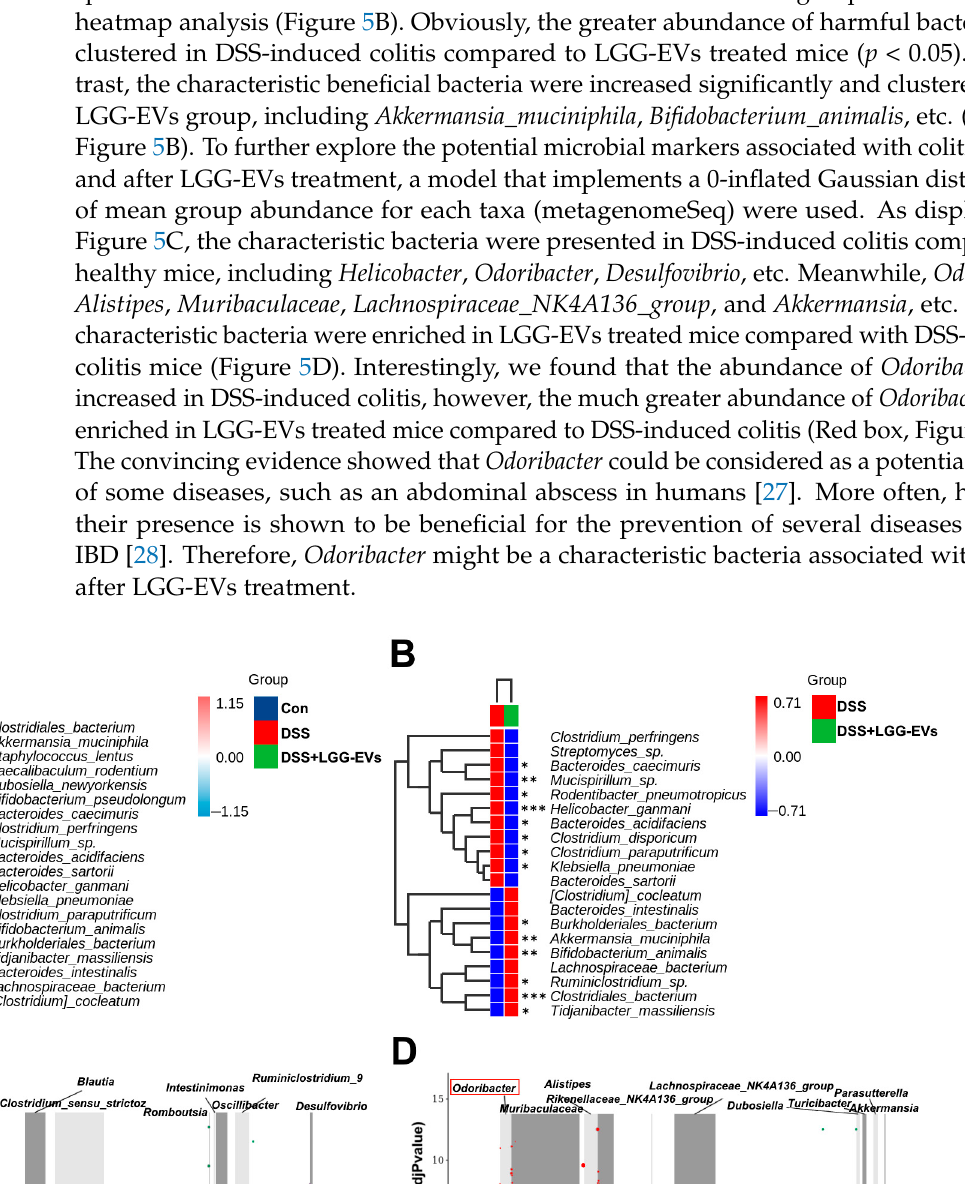
Figure 5. Characterization of the gut microbiota in colitis mice upon LGG-EVs treatment. Heat map showed the significant difference of characterizable bacteria among three groups ( A ) and before and after LGG-EVs treatment ( B ) at the species level. Several significantly differentially abundant taxa enriched in the DSS group ( C ) and LGG-EVs group ( D ) were identified using metagenomeSeq analysis after merging at the lowest taxonomic annotation. * p < 0.05, ** p < 0.01, *** p < 0.001.